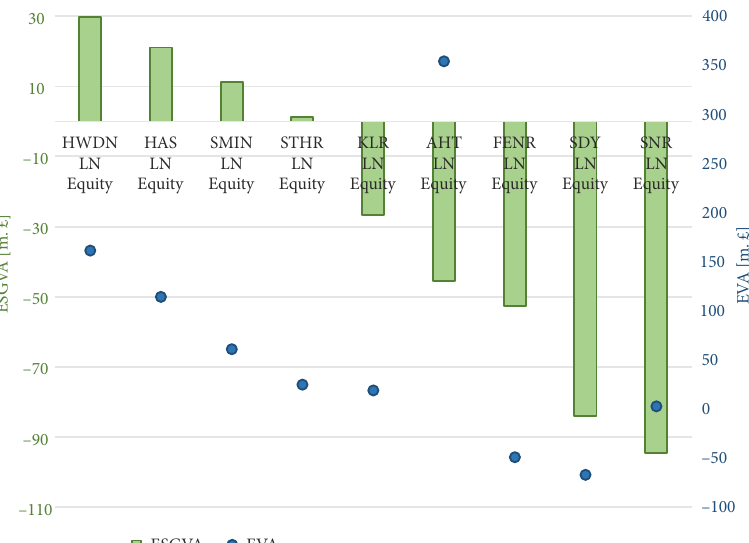
Figure 3. Added value in selected companies according to the ESGVA model and